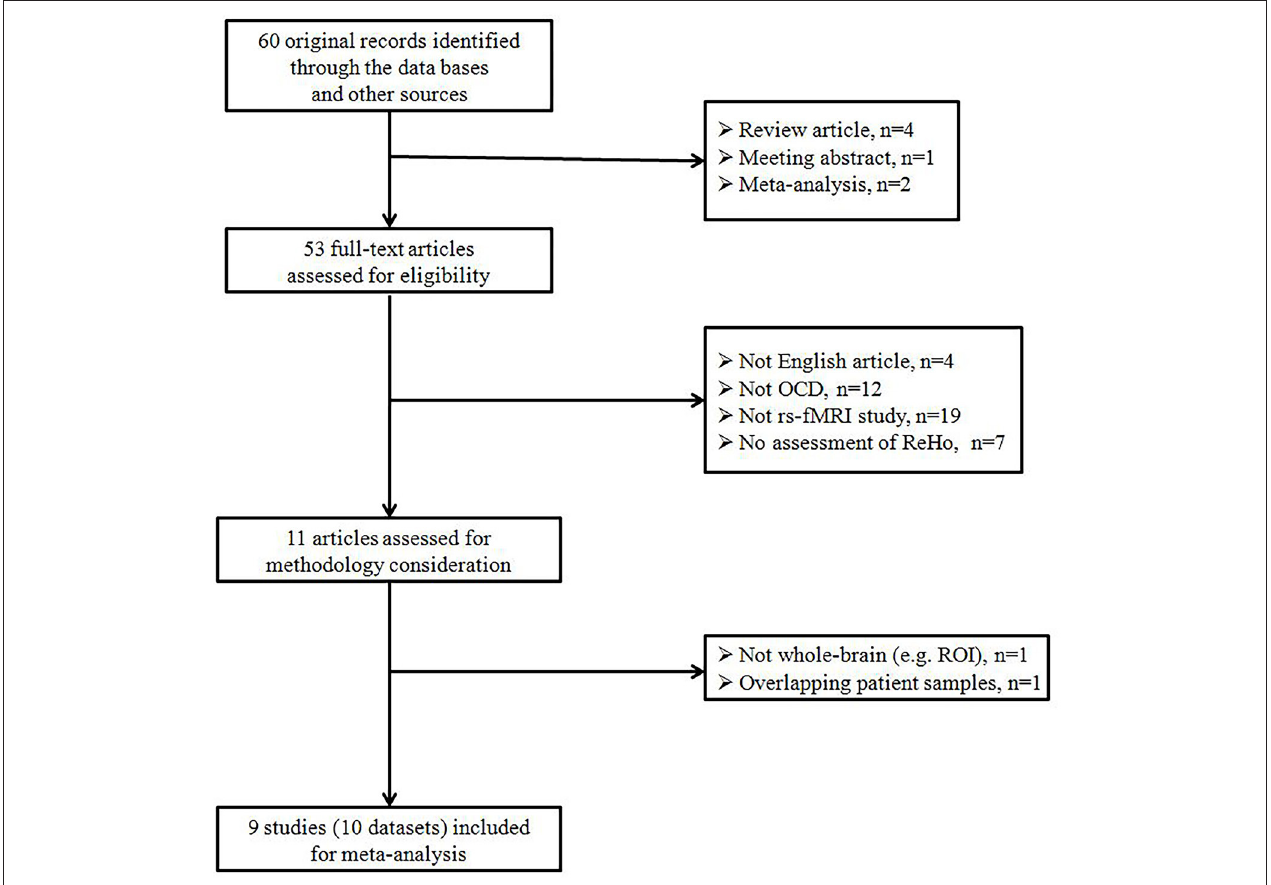
FIGURE 1 | Flow diagram regarding the identification and attrition of studies. OCD, obsessive-compulsive disorder; ReHo, regional homogeneity; ROI, region of interest; rs-fMRI, resting-state functional magnetic resonance imaging.